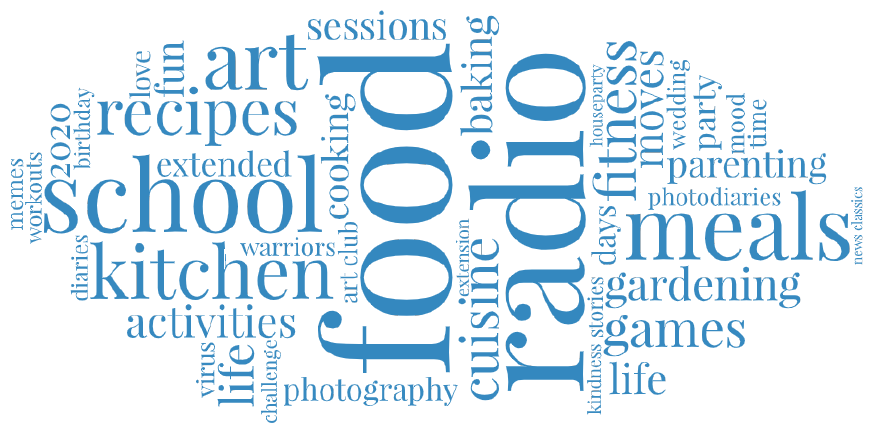
Image 1: Word cloud of the chosen